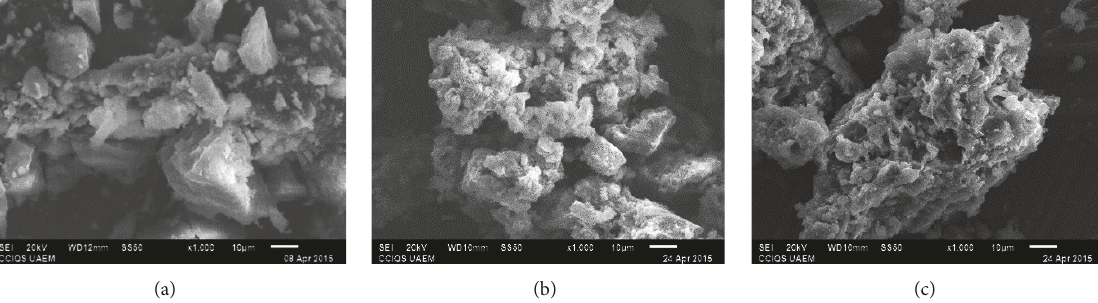
Figure 8: SEM image of the (a) sludge produced in the Remazol yellow-EC process and materials: (b) CAC and (c) CM before adsorption.